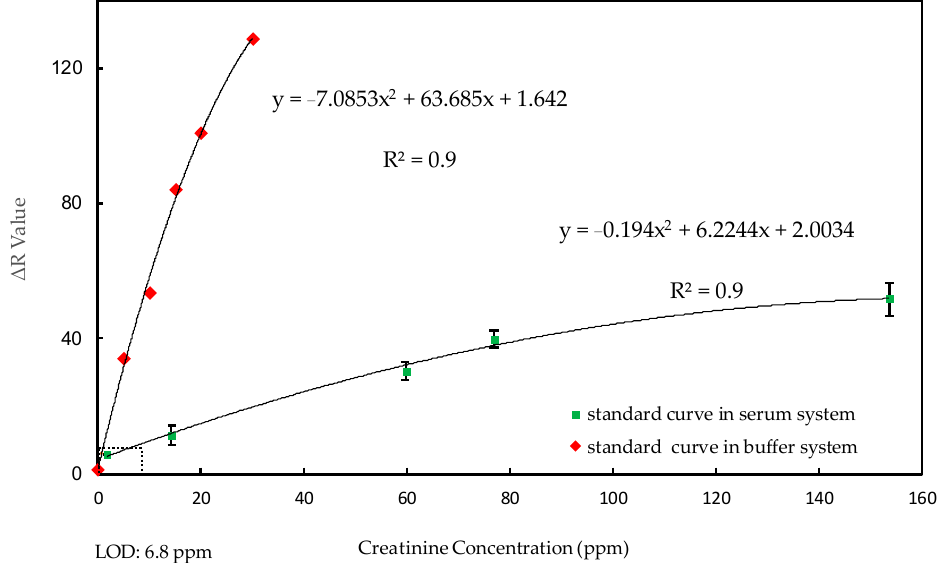
Figure 4. Creatinine standard curve (n = 8, N = 3). Red indicates the standard curve in a buffer system, with a concentration range of 0–30.0 ppm; green indicates the standard curve in a serum system, with a concentration range of 7.3–153.6 mg/dL. Correlation coefficient (R 2 ) of standard curves in both buffer system and serum system equals 0.99.